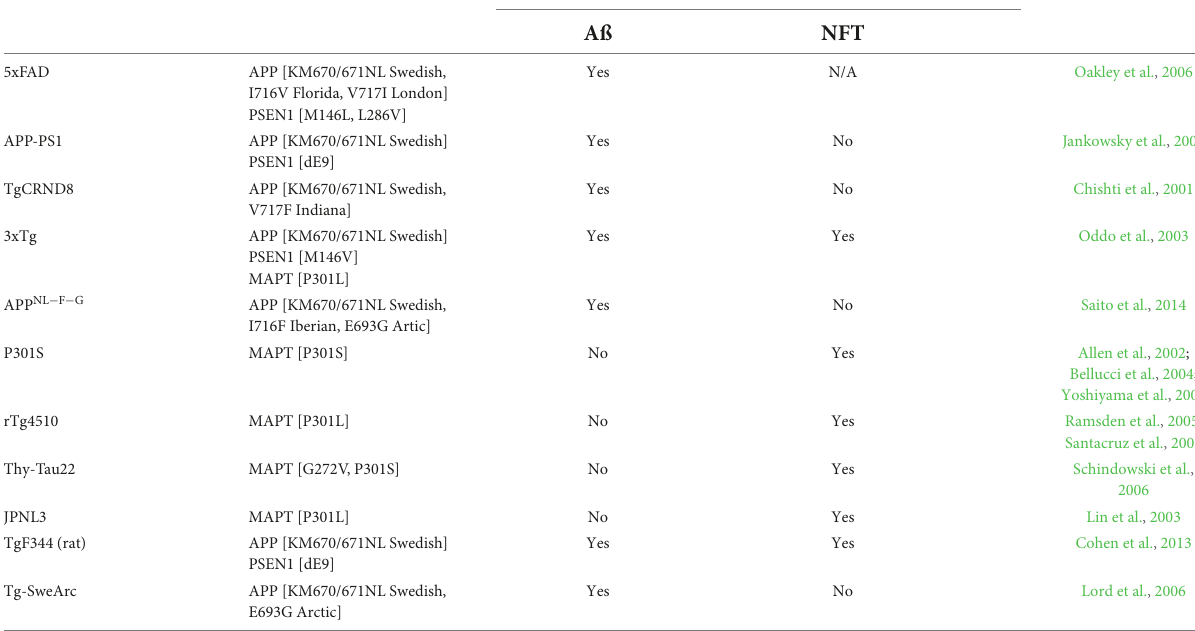
TABLE 1 Mouse models of AD pathology used to investigate microglial and astrocytic heterogeneity. Model Mutations Presence of Aß and/or neurofibrillary tangles